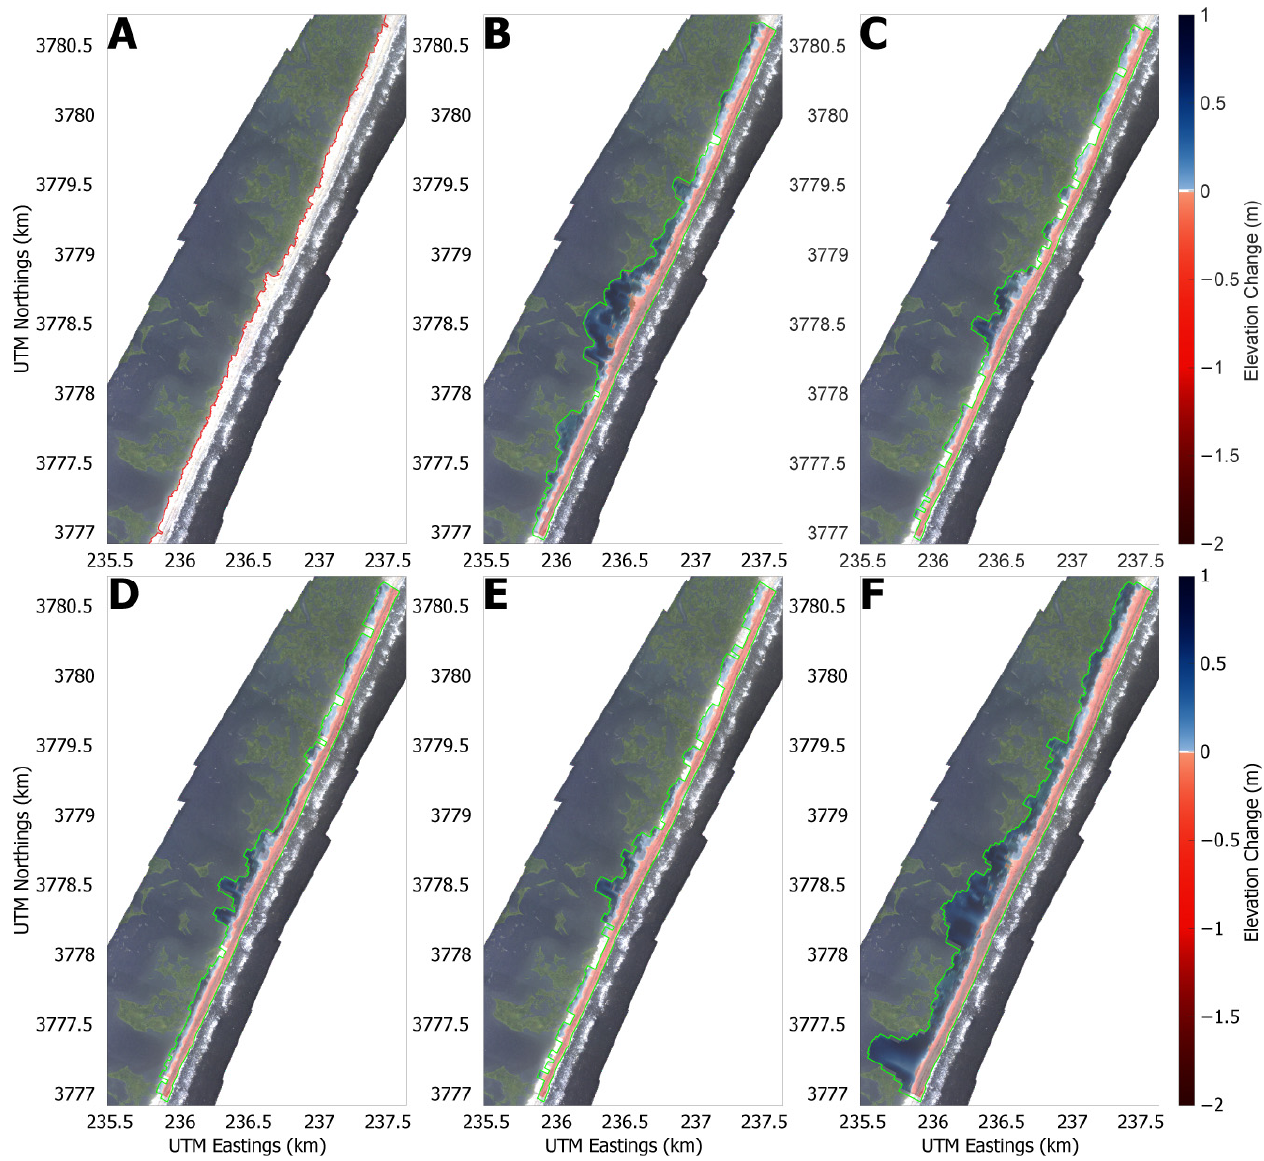
Figure 6. NGS post-Florence imagery ( A ) and outlined overwash deposits for the default simulation ( B ), grain size simulation ( C ), spatially varying friction simulation ( D ), baseline simulation, ( E ) and JONSWAP simulation ( F ) at the southern/central section of Masonboro Island. Erosion is shown in red, and deposition is shown in blue. The green outline is the overwash polygon for each respective simulation.